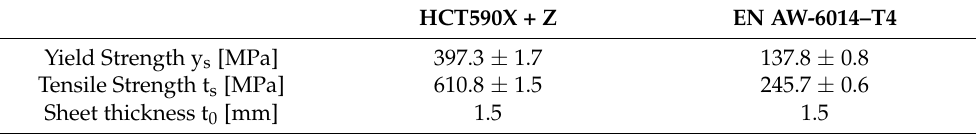
Table 2. Mechanical material properties of HCT590X + Z and EN AW-6014-T4 as obtained from the uniaxial tensile test in rolling direction with a number of tests per material of n =